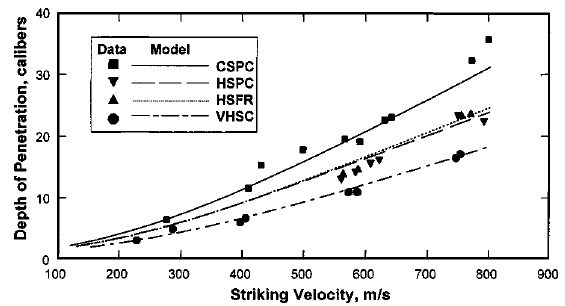
Fig. 3. Comparison of results from penetration experiments into CSPC, HSPC, HSFR, and VHSC concretes and spherical-cavity ex- pansion model